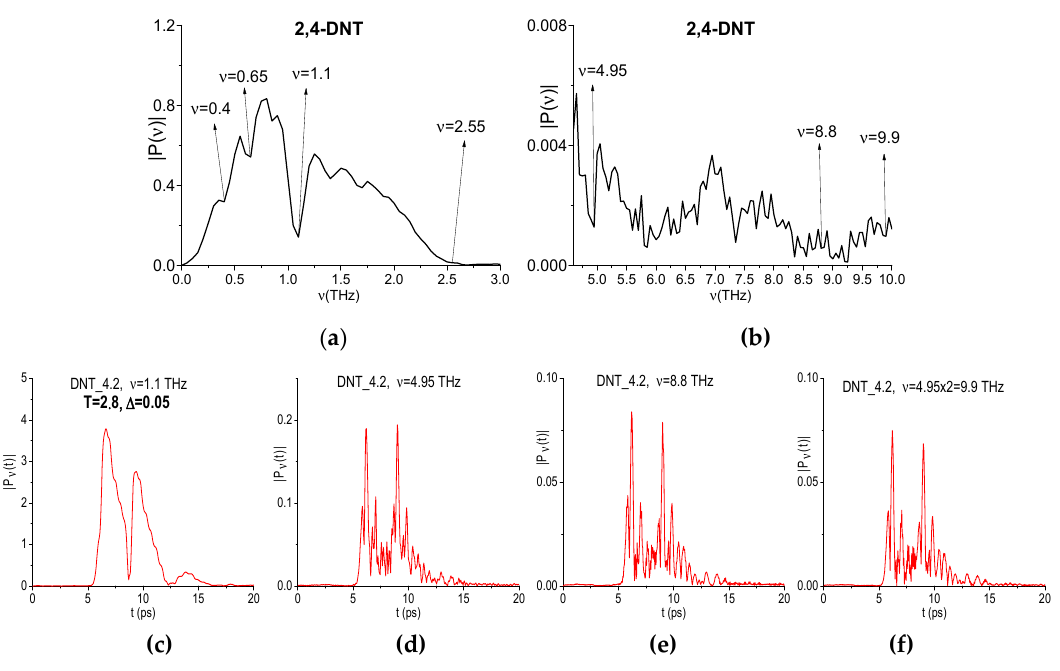
Figure 10. 2,4-DNT spectrum in the frequency ranges ν = [0, 3.0] THz (a) and [4.6, 9.0] THz (b). Evolution of the spectral amplitudes modulus at the frequencies ν = 1.1 THz (c), 4.95 THz (d), 8.8 THz (e), 9.9 THz (f) computed with the window length T = 2.8 ps and window shift Δ = 0.05 ps (c – f)).